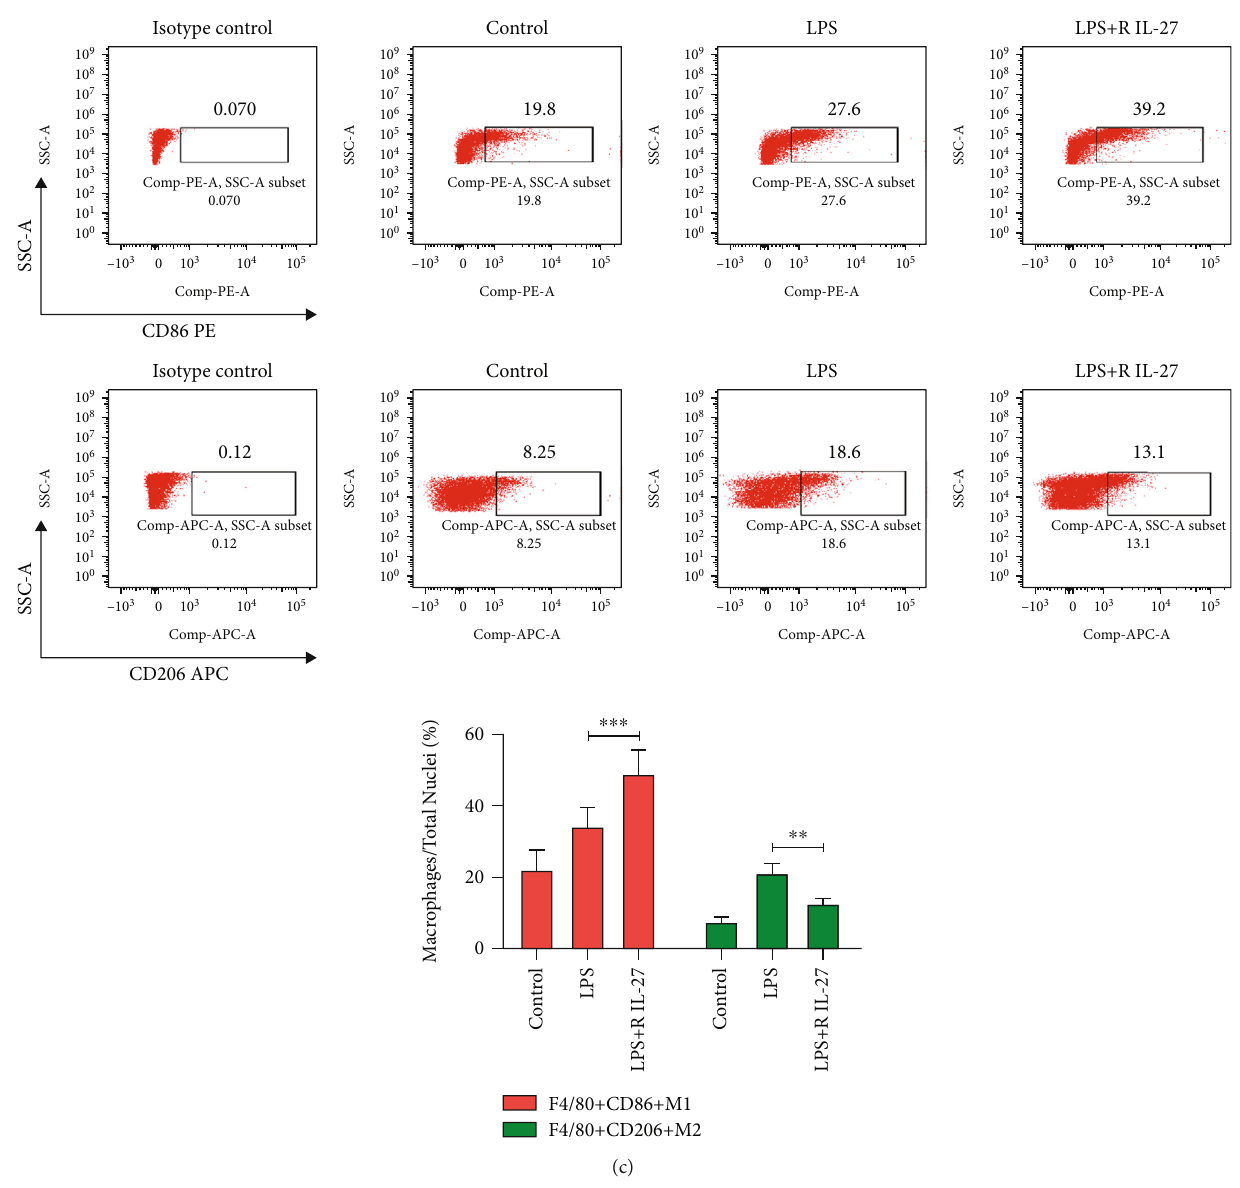
Figure 4: (a) EBI3 and P28 protein and mRNA levels of peritoneal macrophages stimulated by LPS(100ng/ml) (by western-blot and qPCR), ∗∗∗ p < 0 : 001 vs control. (b) IL-6, TNF- α , and IL-1 β levels in cell supernatant after LPS stimulated, with or without recombinant IL-27 (R IL- 27) (by ELISA), ∗ p < 0 : 05 , ∗∗ p < 0 : 01 , ∗∗∗ p < 0 : 001 . (c) M1 and M2 polarization of peritoneal macrophages after LPS stimulated, with or without recombinant IL-27 (R IL-27) (by fl ow cytometry). ∗∗ p < 0 : 01 , ∗∗∗ p < 0 : 001